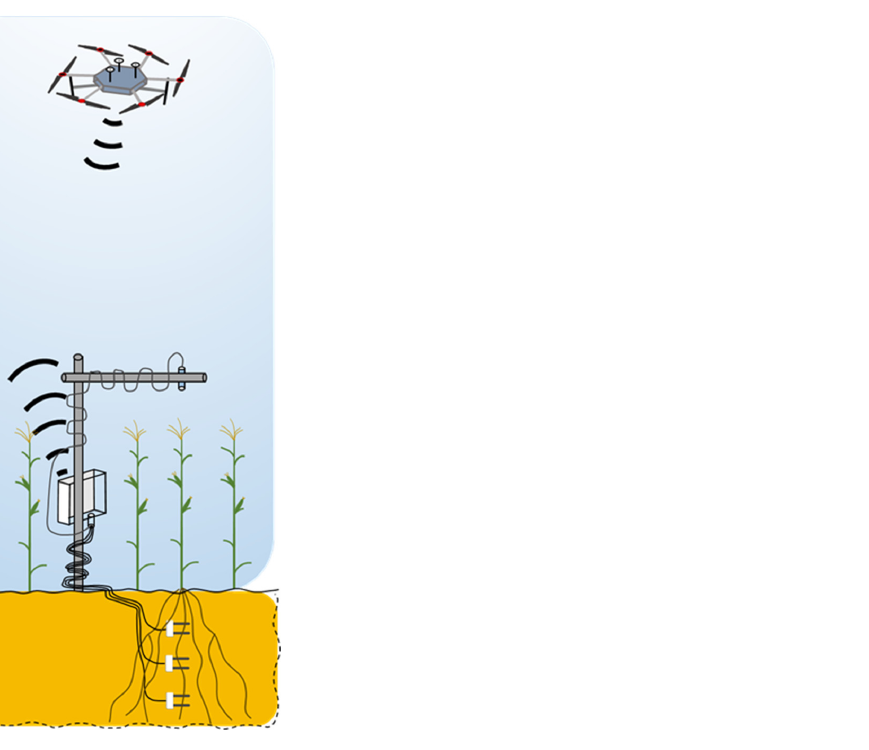
Table 2. The planting date, the observed vegetative and reproductive growth stage dates for maize during the 2020 and 2021 growing seasons.